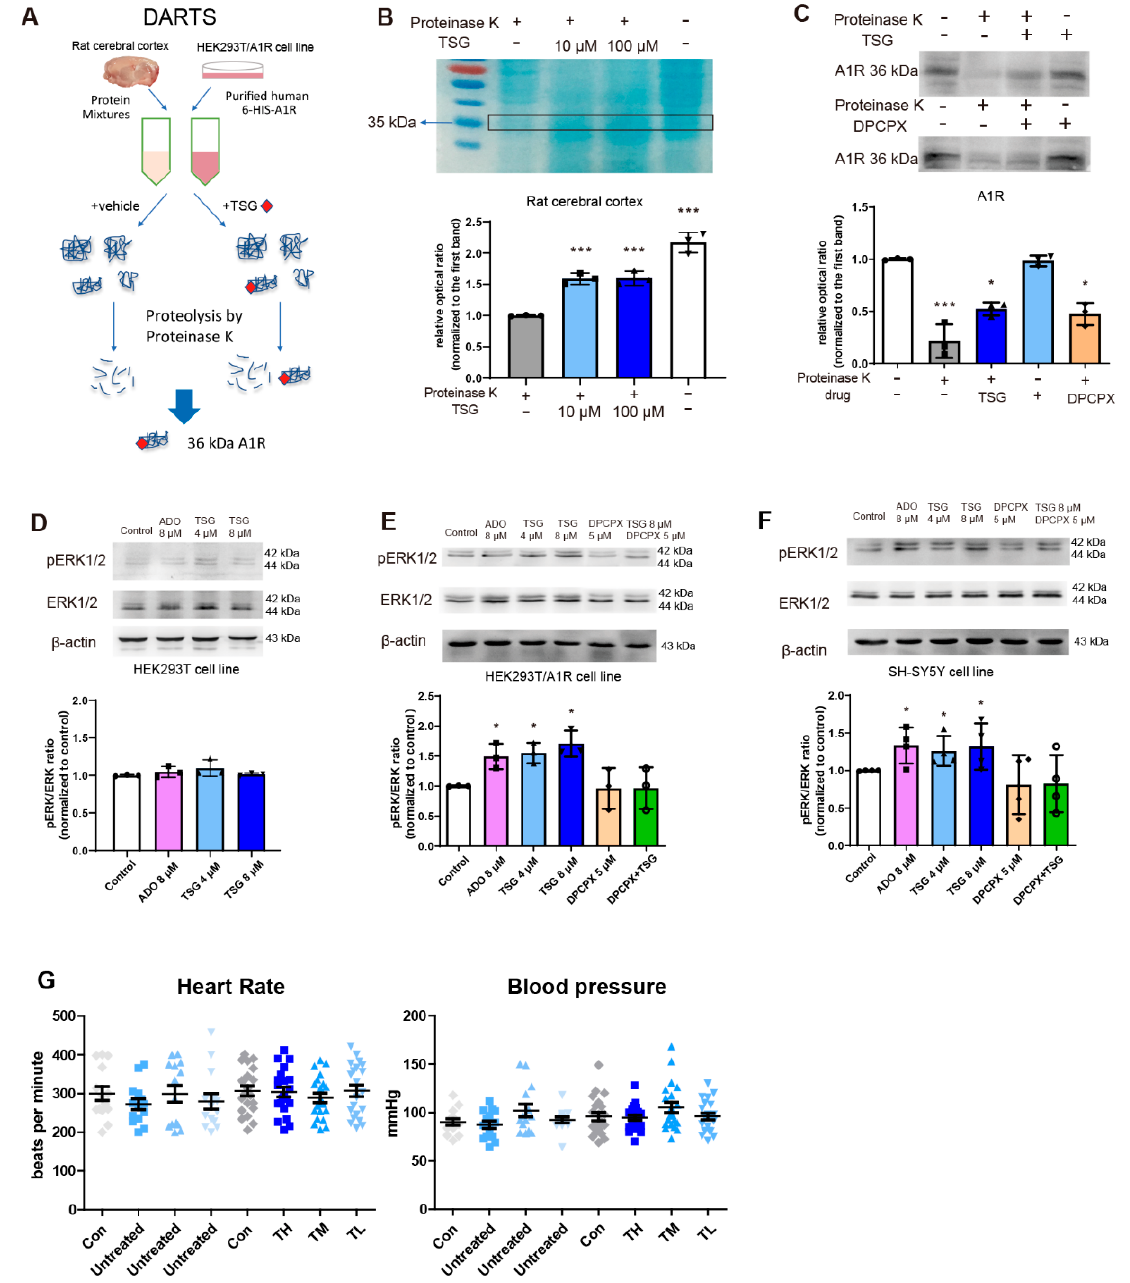
Figure 6. TSG targeted A1R and activated ERK1/2 phosphorylation, a downstream signal of A1R. ( A ) Experimental procedure of DARTS with TSG. ( B ) Coomassie SimplyBlue staining of the cerebral lysates subjected to proteinase K digestion ( n = 3). ( C ) SDS-PAGE analysis of the cellular lysates subjected to proteinase K digestion with A1R antibody staining ( n = 3). ( D ) The phosphorylation of ERK1/2 in HEK293T cells without A1R was detected by Western blot after 24 h incubation with adenosine (ADO, 8 µ M) and TSG (4 µ M and 8 µ M). ( E , F ) The phosphorylation of ERK1/2 in HEK293T/A1R cells and SH-SY5Y cells was detected by Western blot after 24 h treatment of ADO (8 µ M), DPCPX (5 µ M) and TSG (4 µ M and 8 µ M). The gray value was analyzed by ImageJ software. All the values were expressed as mean ± SD, n ≥ 3. ( G ) The heart rate and blood pressure of rats 14 days before TSG treatment and 21 days with TSG treatment, respectively. TSG was treated for rats for 21 days with 40, 20 and 10 mg/kg (s.c., twice a day) corresponding to the TH, TM and TL groups. Each point represents the mean value of blood pressure and heart rate of rats each day in the same group. The observed vertical bar represents the mean ± SD of the blood pressure and heart rate at 14 days and 21 days, respectively. * p < 0.05, ** p < 0.01 and *** p < 0.001, other groups vs Control group.